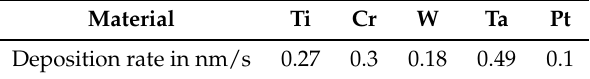
Table 1. Deposition rates of the various seed layer